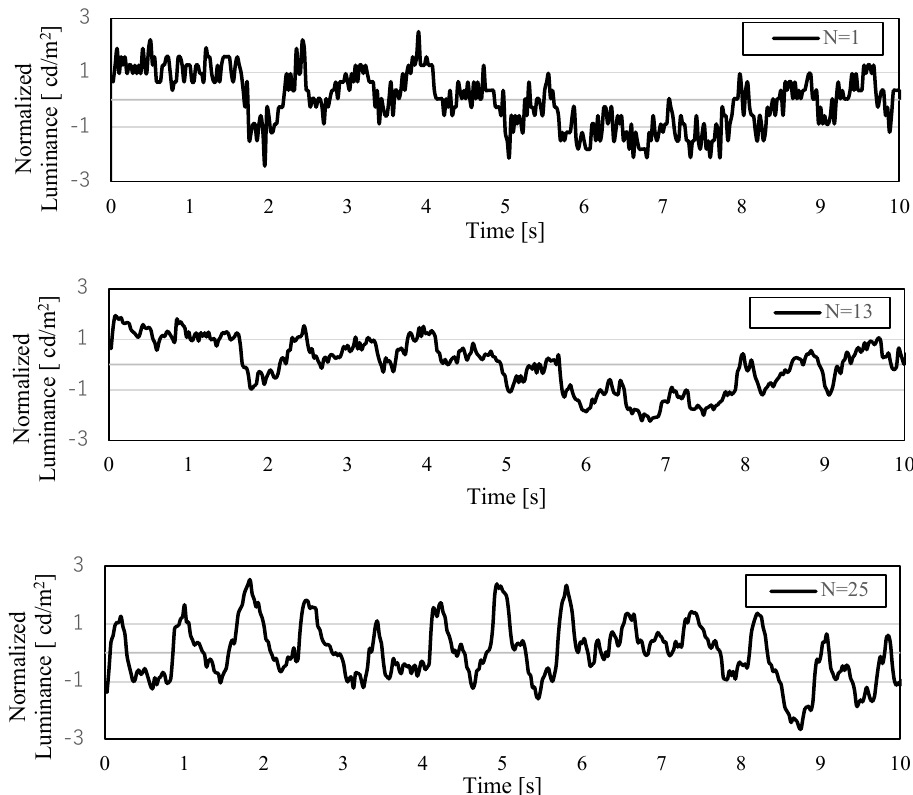
Figure 12. Effect of the kernel size N on noise reduction in the AVF pulse wave measurement. The random noise on the AVF pulse wave was suppressed by the moving-average filtering. Larger kernel size made the observed AVF pulse wave